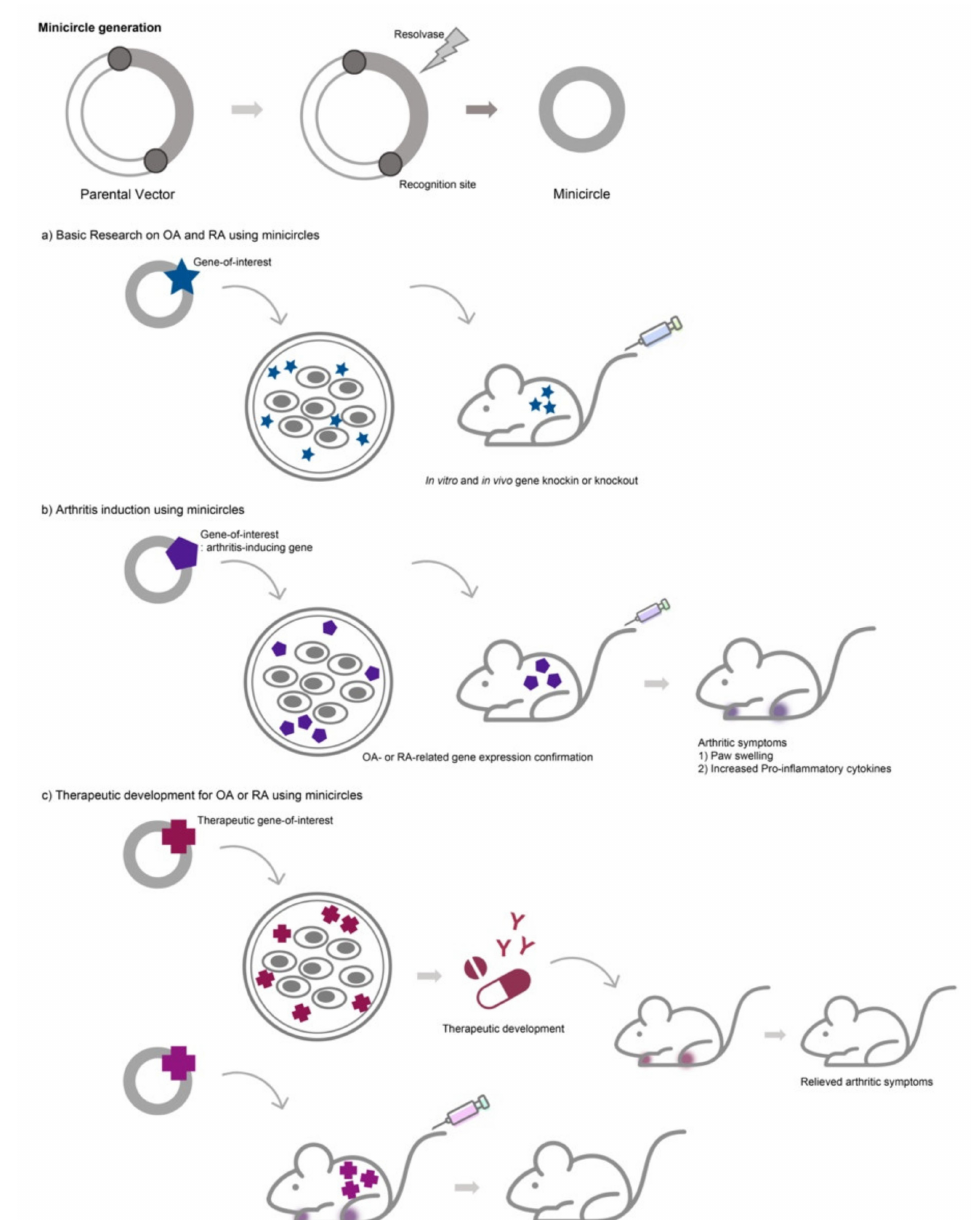
Figure 1. General application of minicircles for studies on arthritic diseases. Minicircles are generated from parental vectors. Studies using minicircles on arthritic diseases can be categorized as ( a ) in vitro and in vivo basic research on arthritic diseases, ( b ) inducing arthritis using minicircles for in vitro and in vivo disease modeling, and ( c ) gene therapy for treating arthritic diseases. Minicircles can be used directly as a tool for gene therapy in some cases or as delivery systems into cells to generate cell-based therapeutics for